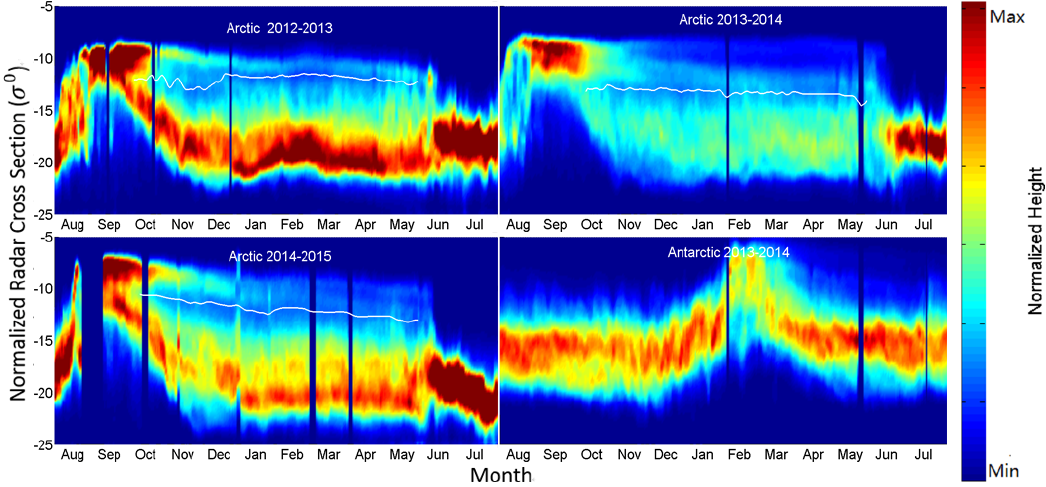
Figure 9. The temporal series of the histograms of HY-2A/SCAT Arctic V-pol σ 0 values for the winter of 2012/2013 ( top left ), 2013/2014 ( top right ) and 2014/2015 ( bottom left ) and Antarctic for the winter of 2013/2014 ( bottom right ). The Arctic sea ice distribution demonstrates a separation of modes corresponding to FY ice and MY ice, and the white curves are varying thresholds in every winter. Whereas the Antarctic sea ice distribution does not demonstrate such